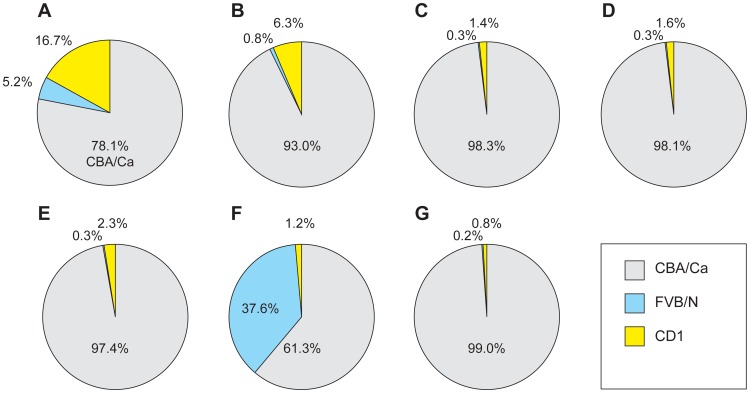
Genetic background of mice used at different stages of the study.(A) Adult mice from (Le-CreTg/−; Pax6+/+ × Le-Cre−/−; Pax6fl/+) crosses in stage 1. (B) Adult mice from (Le-CreTg/−; Pax6+/+ × Le-Cre−/−; Pax6fl/+) crosses used for wound healing experiment in stage 2. (C) Fetal and juvenile mice from (Le-CreTg/−; Pax6+/+ × Le-Cre−/−; Pax6fl/+) crosses in stage 3. (D) Adult mice from (Le-CreTg/−; Pax6+/+ × Le-Cre−/−; Pax6fl/+) crosses in stage 3. (E) Adult reporter mice from (Le-CreTg/− × Z/AP) crosses in stage 3. (F) Adult mice from (Le-CreTg/−; Pax6+/+ × Le-Cre−/−; Pax6fl/+) crosses in stage 4. (G) Adult mice from (Le-CreTg/−; Pax6fl/+ × PAX77Tg/−) crosses. See Table S1 and Materials and Methods for further details.